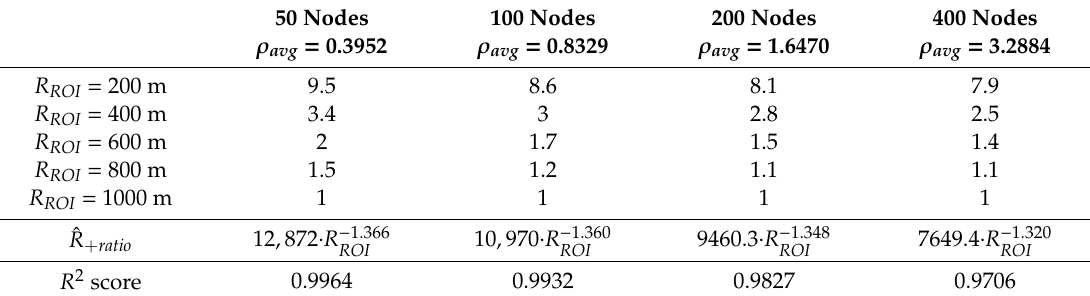
Table 2. Optimal R + ratio values obtained for simulations considering di ff erent density conditions and distinct regions of interest (ROI) radius values.